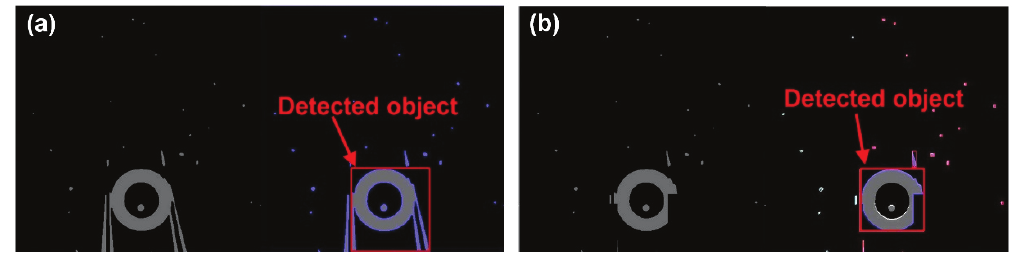
Figure 5. Detecting the grasped objects. ( a ) Before removing two fingers; ( b ) After removing two